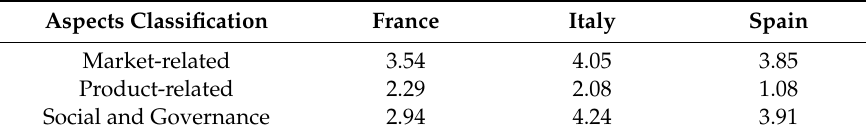
Table 7. France, Italy, and Spain categories average